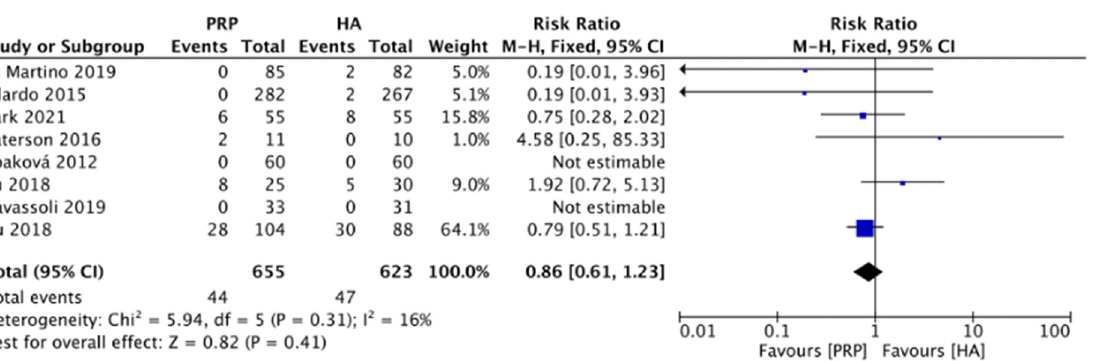
Figure 10. Trials of LR-PRP versus HA. Forest plot of adverse effects. (M-H: Mantel Haenszel; CI, confidence interval).